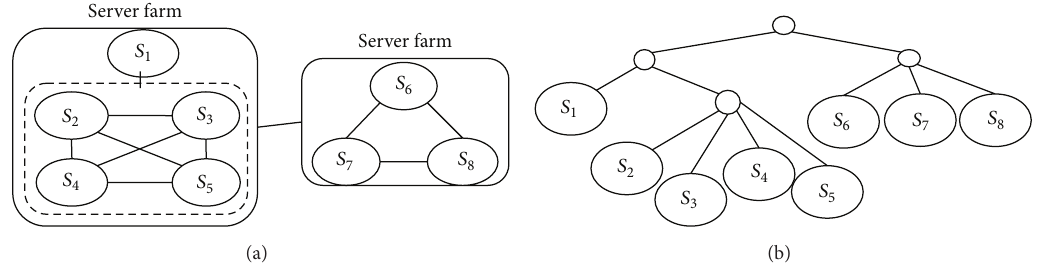
Figure 2: An example of a simple cloud platform and its tree-structured